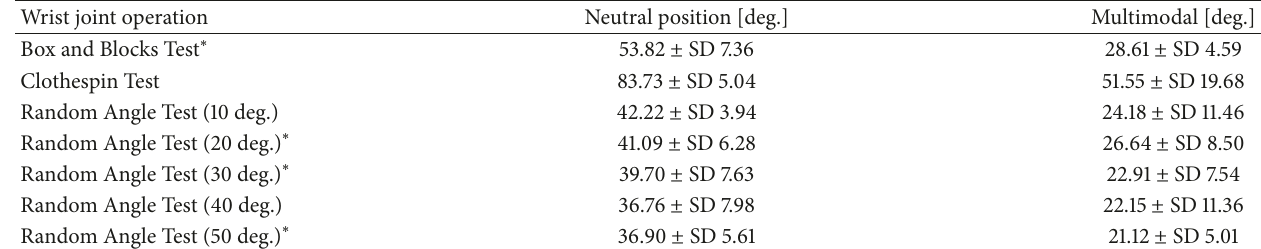
Table 2: Mean of Range of Roll ( ∗ 𝑝 < 0.05 , 𝑁 = 4 ).